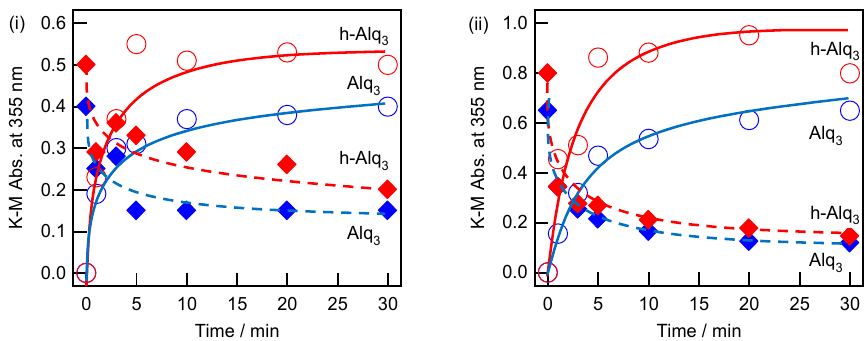
Figure 8. Time-dependence of the K–M absorbance at 355 nm for the Alq 3 /APA ( ○ ) and h-Alq 3 /APA ( ○ ) samples immersed in 1 mM Alq 3 /EtOH and HQ/EtOH solutions respectively, and for the samples of Alq 3 /APA ( ◆ ) and h-Alq 3 /APA ( ◆ ) in distilled water after 30-min adsorption. The notations ( i , ii ) correspond to the preparation conditions listed in Table 1. Table 3. K–M absorbance for the Alq 3 /APA and h-Alq 3 /APA samples after 30-min adsorption ( Ads. 30 ) in 1 mM Alq 3 /EtOH and HQ/EtOH solutions, respectively, and 30-min desorption ( Des. 30 ) in water, as well as the corresponding desorbed amounts ( ∆ = Ads. 30 − Des. 30 ) and desorption fraction ( Dr% = ∆ / Ads. 30 × 100).